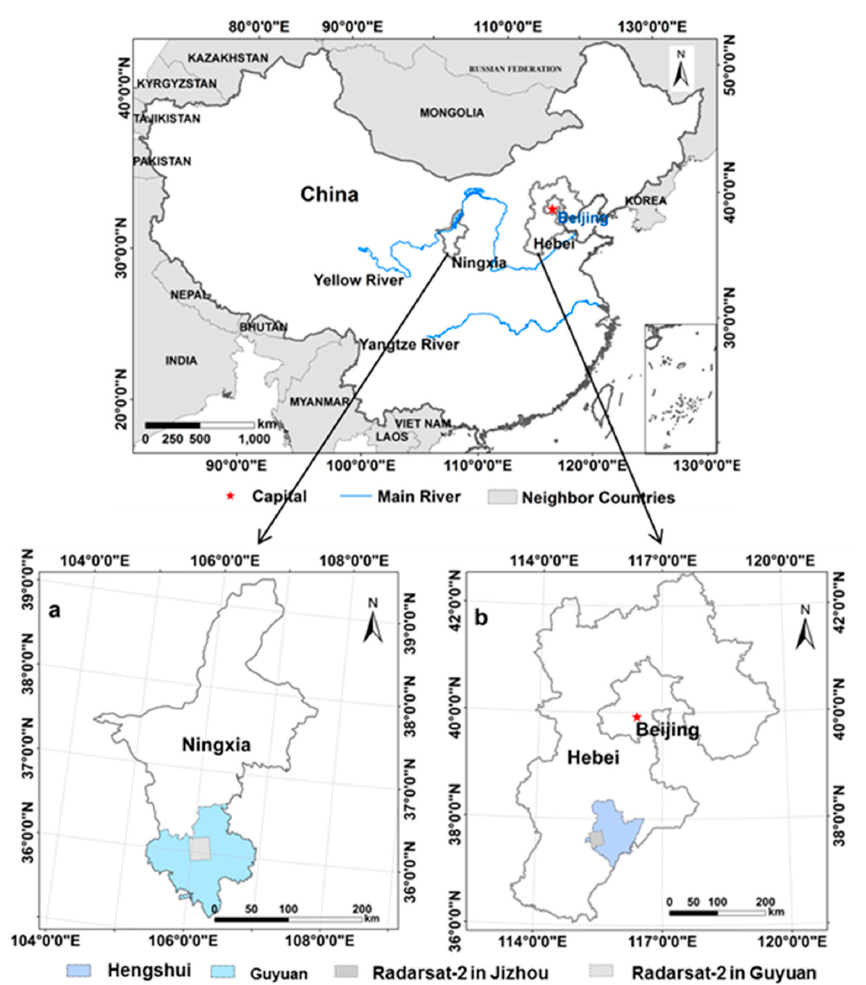
Figure 1. The location of the study areas (( a ) is the location of the study area in Guyuan; and ( b ) is the location of the study area in Jizhou).